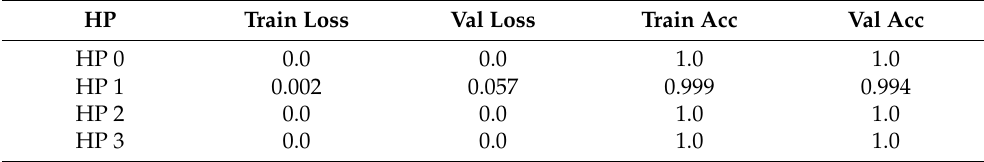
Table 5. Final loss and accuracy of four load conditions.